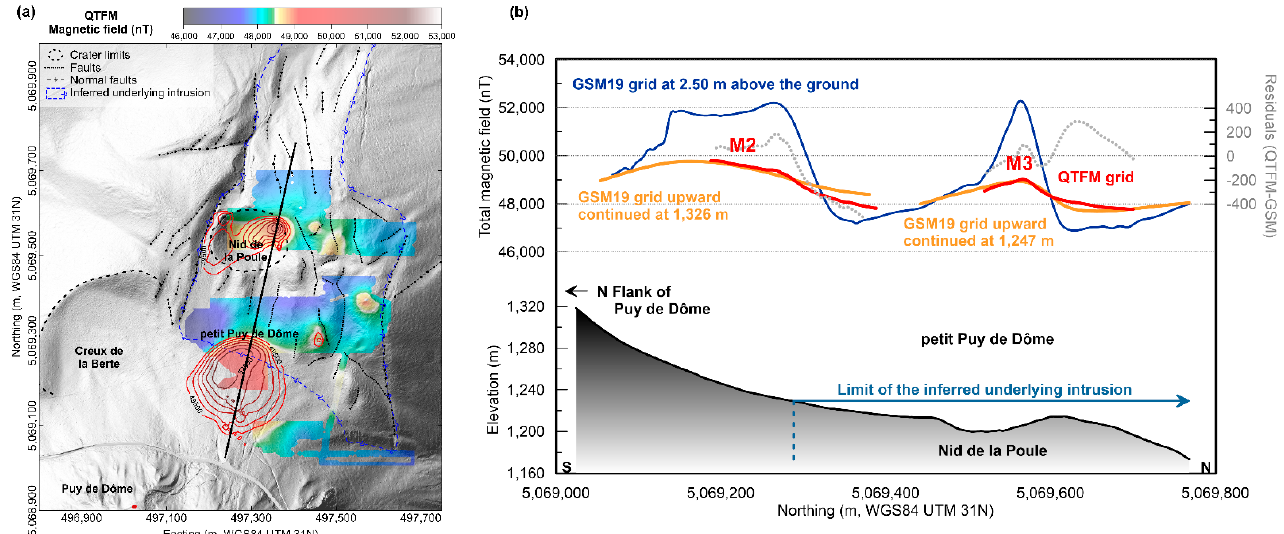
Figure 5. ( a,b ) Comparison of QTFM and GSM19 magnetic measurements along the south to north profile (black line on the left-hand diagram) crossing the two main positive anomalies. Residuals are shown by a grey dotted line.